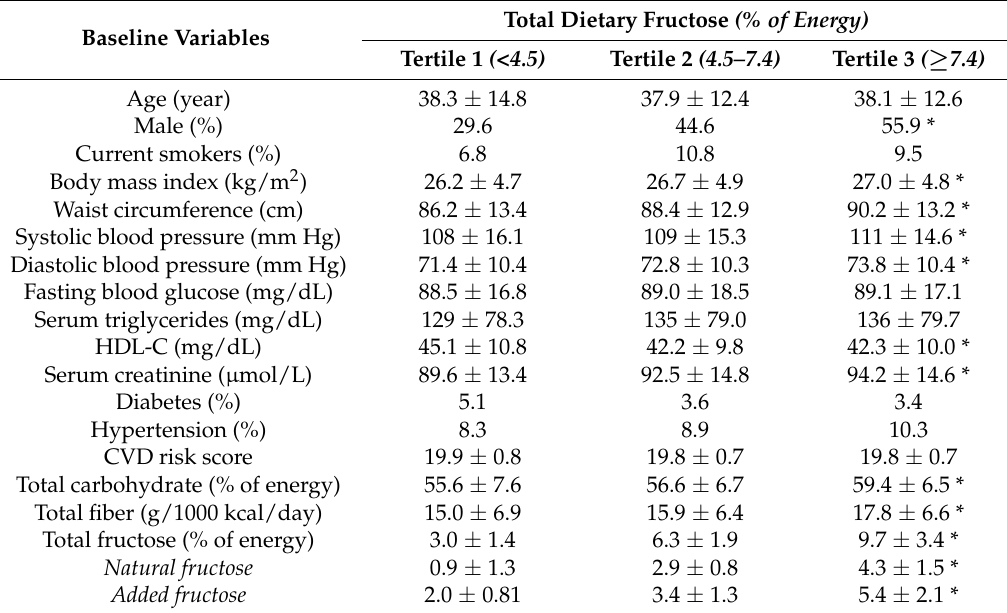
Table 1. Baseline characteristics of the participants across categories of total fructose intakes ( n = 2369).